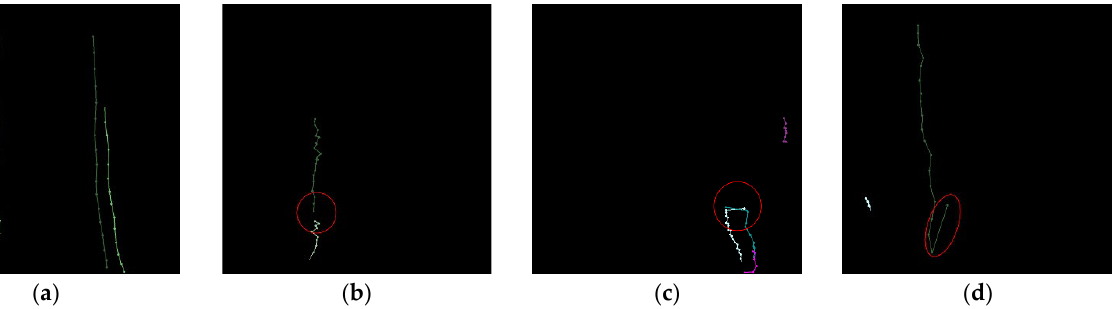
Figure 11. Trajectories of ( a ) the correctly tracked objects in scenes, and violating three criteria; ( b ) connectivity; ( c ) crossing; and ( d ) directivity.